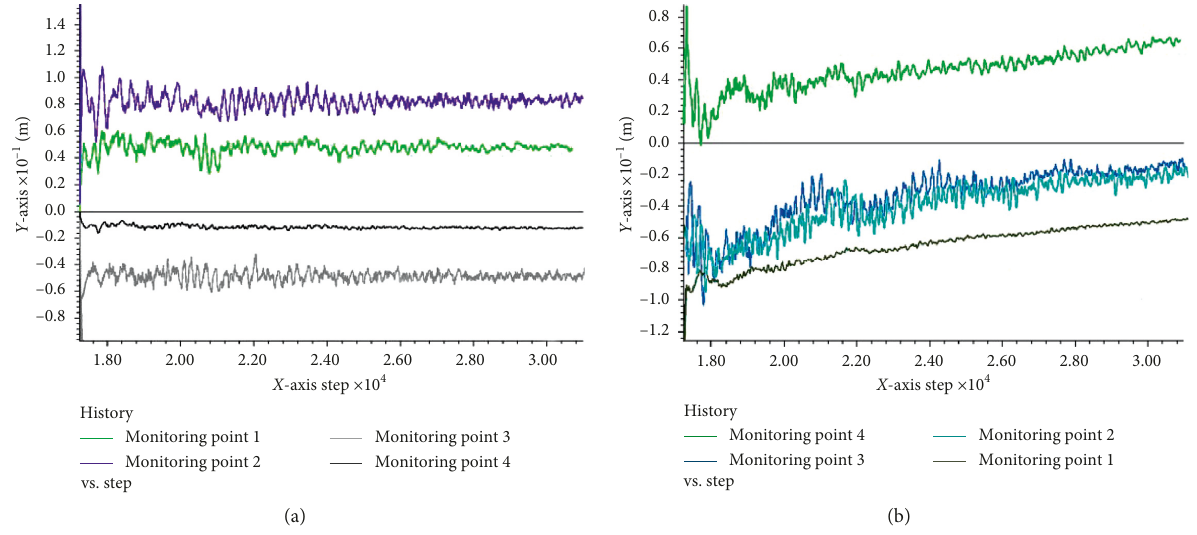
Figure 5: Displacement response diagrams after one dynamic load. (a) X -direction displacement and (b) Z -direction displacement.